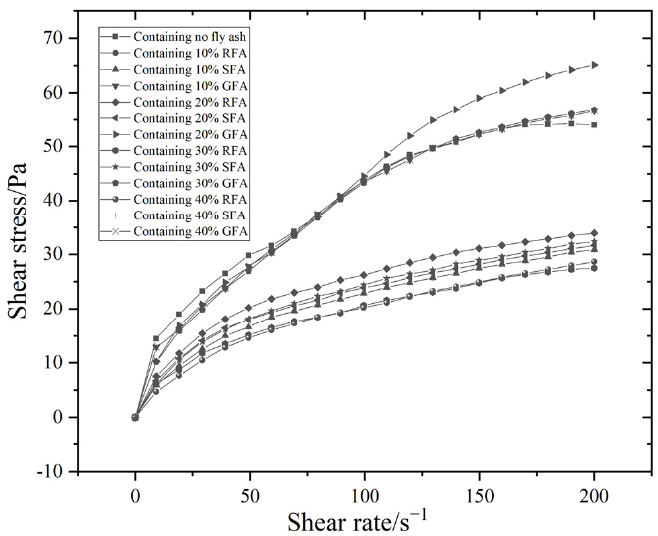
Figure 5. Shear stress of cement paste.